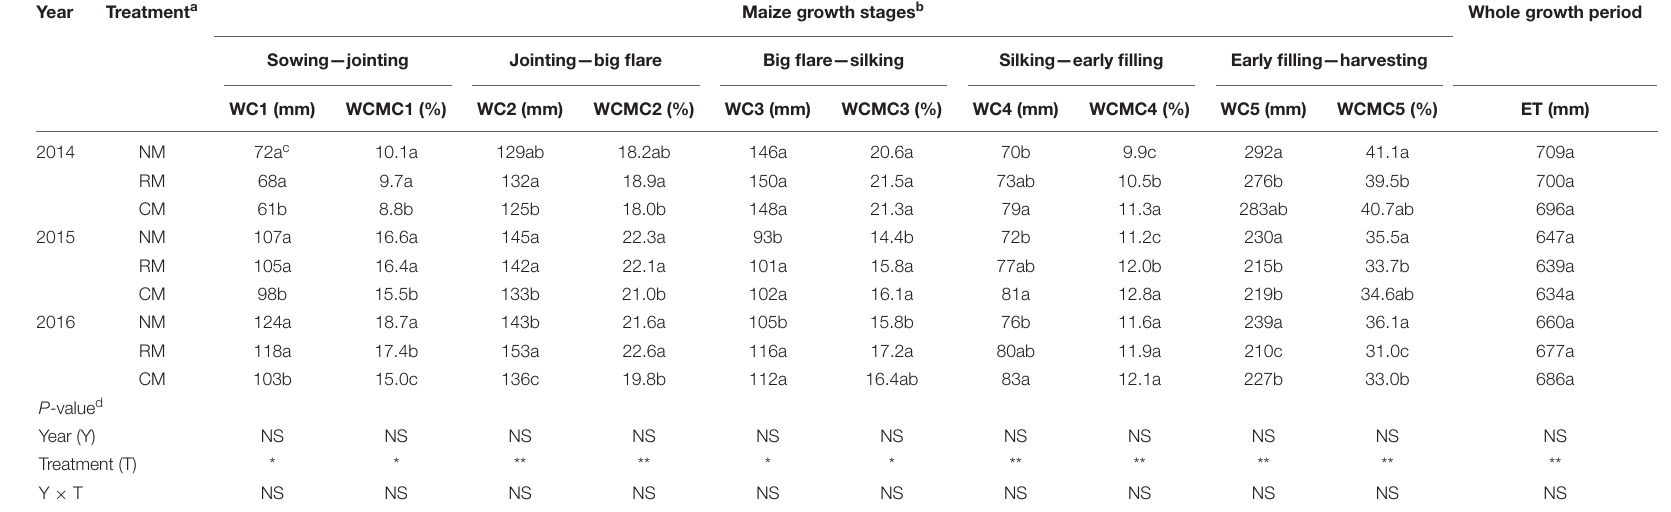
TABLE 4 | Water consumption and water consumption modulus coefficient of maize at each of growth stage with different plastic management practices from 2014 to 2016 in an arid oasis region.